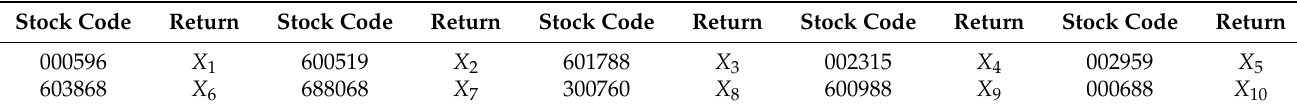
Table 1. The assets from the Chinese stock market.